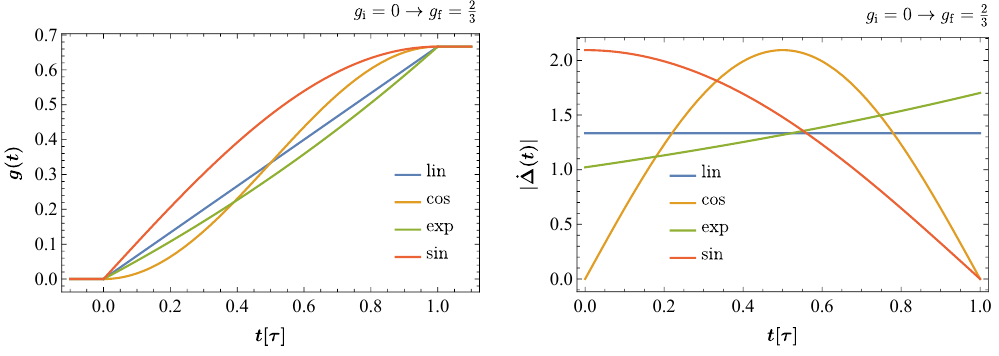
= 0 to g = 2 . Right: Corresponding i f 3